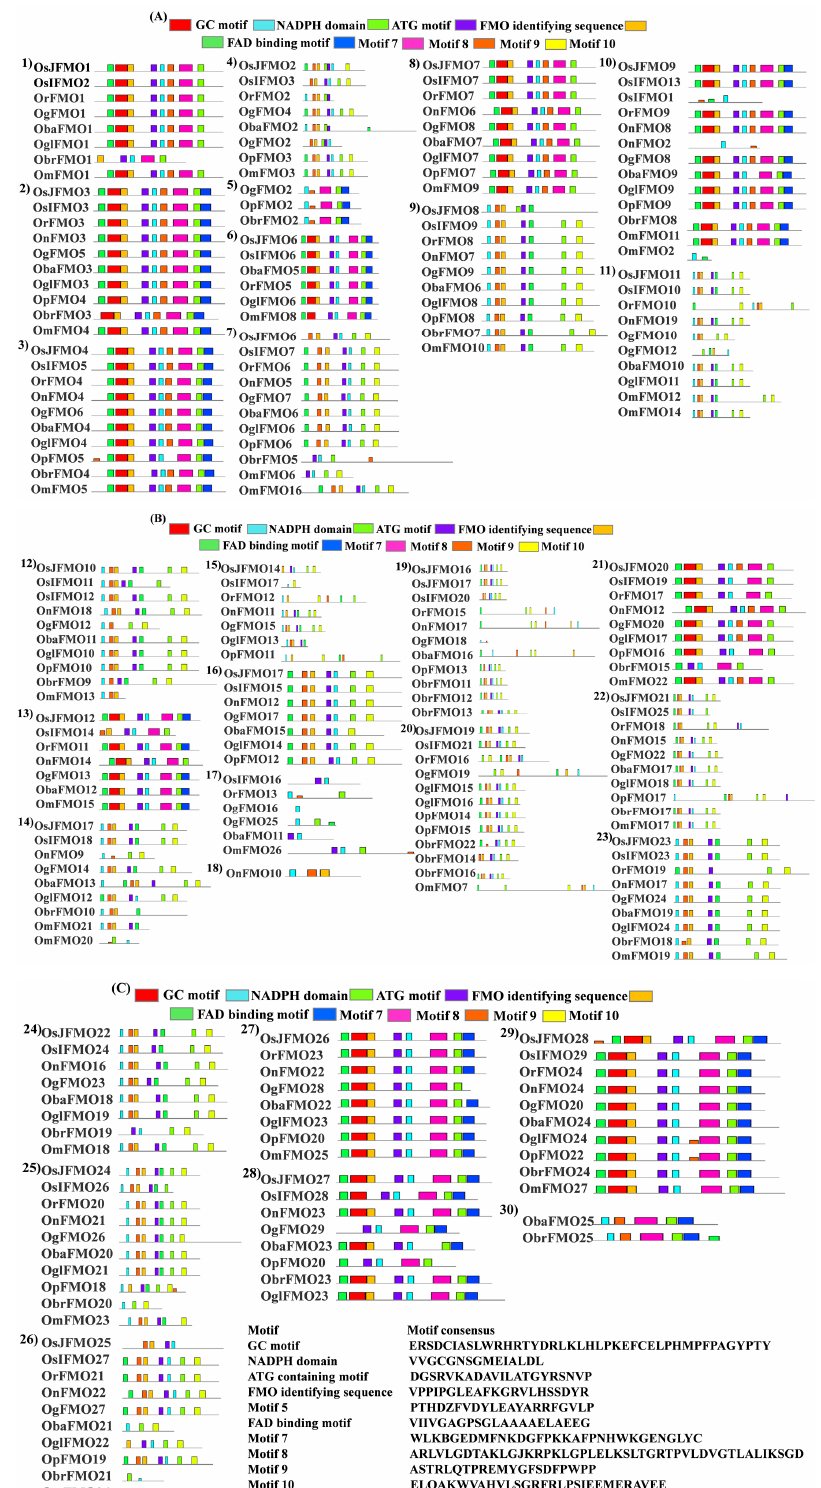
Figure 3. Schematic representation of the conserved FMO-identifying motifs in the FMO proteins in wild and cultivated rice. FMO-identifying motifs previously reported in literature were searched for in the FMO protein sequences of the cultivated Oryza sativa subsp. japonica and wild species, Oryza nivara. The motif sequences have been marked by colours representing each of the conserved motifs, bright green: FAD binding domain; red: GC motif, violet: FMO-identifying sequence; cyan: NADPH domain and light olive green: ATG-containing motif.